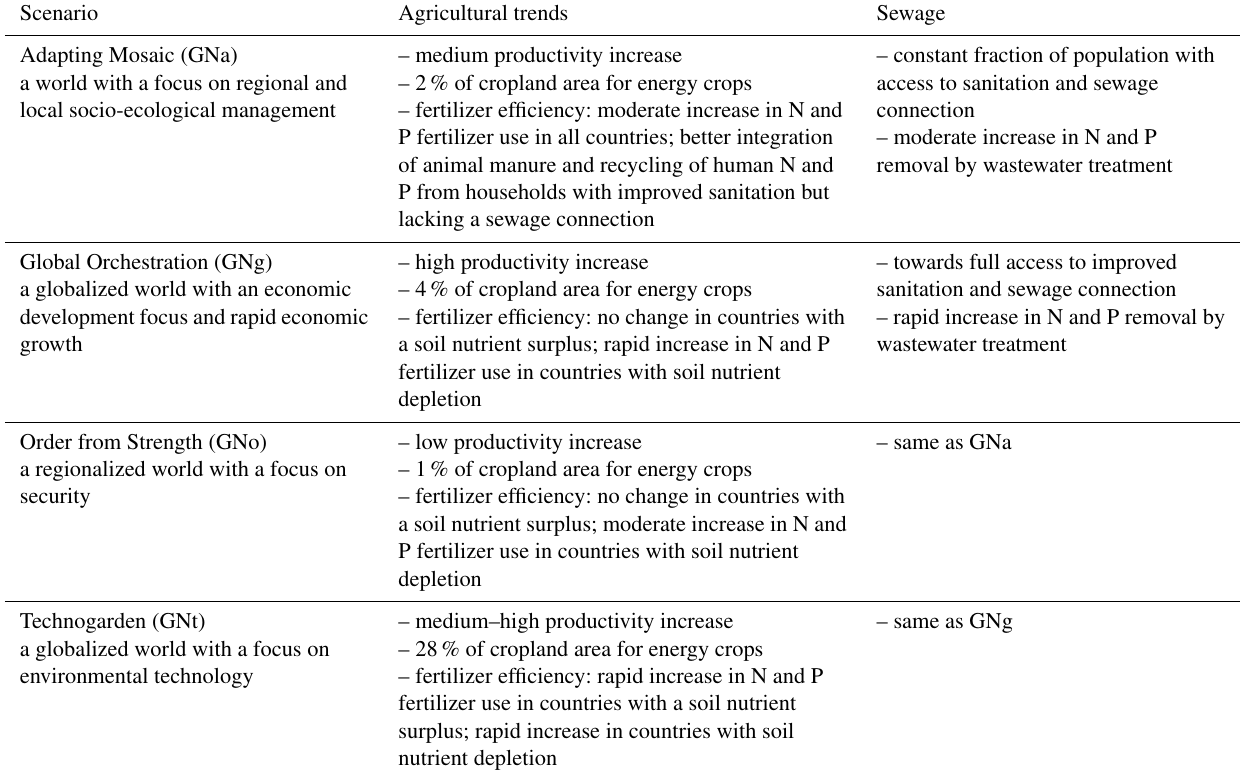
Table 1. Brief introduction to future scenarios for river nutrient export used in Global NEWS 2 (Seitzinger et al.,